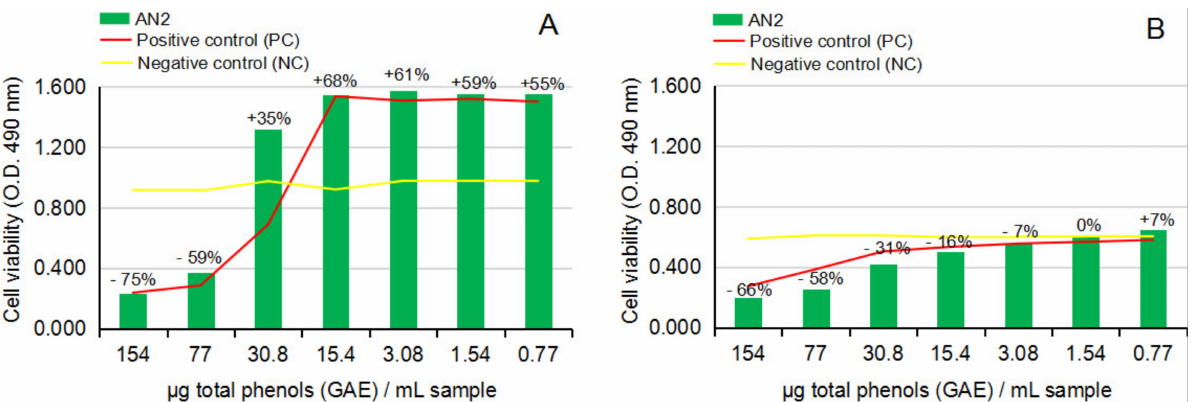
Figure 8. Effect of hot ethanolic extract from dried Anemone nemorosa L. plant material (AN2) on human normal brain cell line NHA and human tumor brain cell line U87, in cytotoxicity MTS assay. ( A ) NHA cell line viability after 24 h of exposure to test vegetal extract AN2. ( B ) U87 cell line viability after 24 h of exposure to test vegetal extract AN2. All determinations were made in triplicate series, and the results are calculated as an average. The graphs present the percentage of cell viability in each dilution point series by comparison to negative control point series (CN). By statistical calculation, the results on the NHA cell line were not statistically significant ( p > 0.05, n = 3), while the results on the U87 cell lines were statistically significant ( p < 0.05, n =